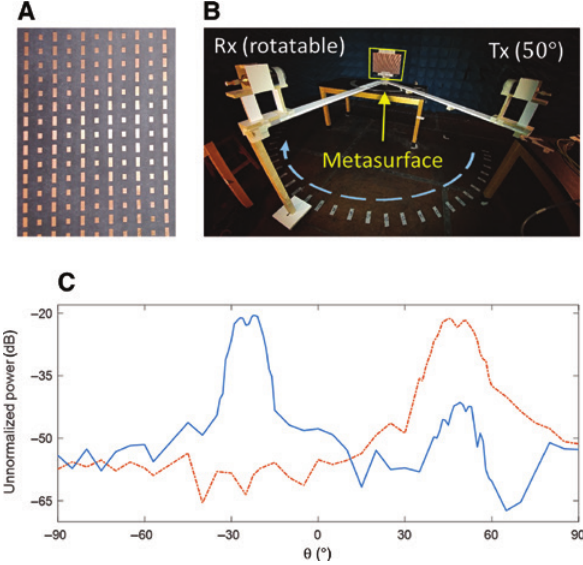
Figure 18: Full-wave simulation of the anomalous reflection BHM. (A) Electric field magnitudes of the incident (left) and scattered (right) waves. The shaded area denotes the metasurface, black boxes denote the location of the dipoles. Obtained from [71]. (B) Top panel: simulated scattering for truncated BHM (blue, solid), compared alongside that for a metallic plate with the same size and shape (red, dashdot). Bottom panel: same as the top panel but over a wide bandwidth. Displayed frequencies are (left to right) 22 GHz, 23 GHz, 24 GHz, 25.5 GHz, 27 GHz, and 28.5 GHz. Obtained from [71].